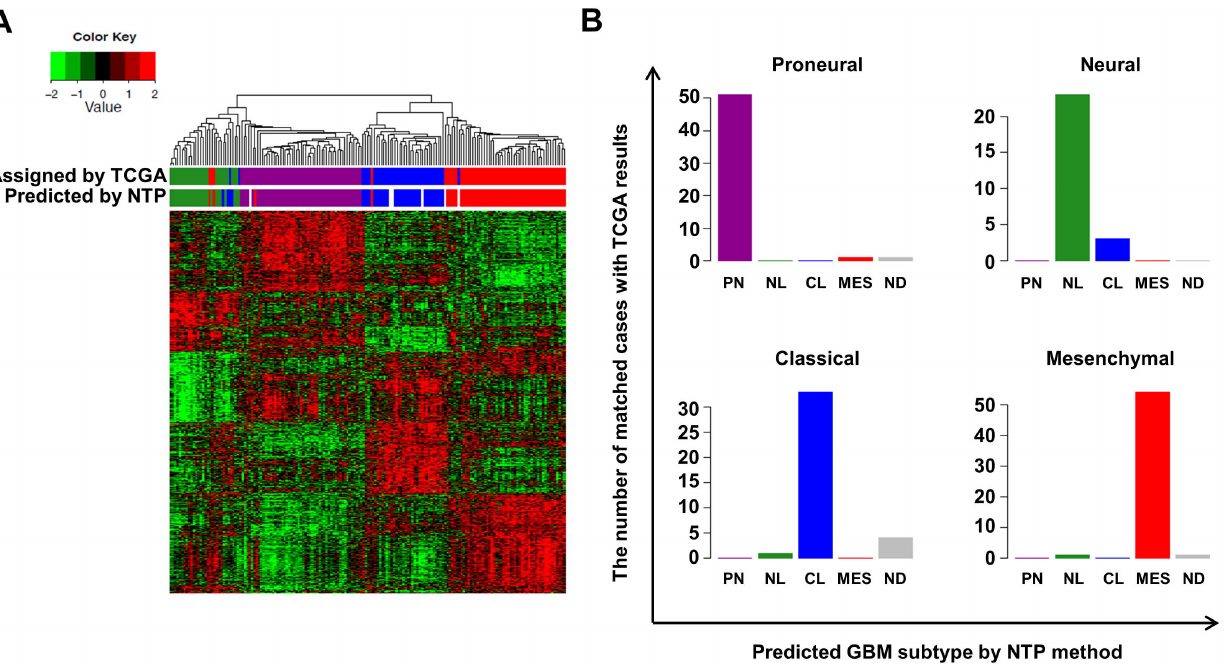
Figure 1. The ‘NTP method’ predicting GBM subtypes. ( A ) Hierarchical clustering using expression of 840 genes of 173 TCGA core GBM samples. The hierarchical clustering results were compared with the results of the NTP method (Predicted by NTP) and the previous reports by TCGA (Assigned by TCGA). Green, purple, blue, and red=neural (NL), proneural (PN), classical (CL), and mesenchymal (MES) subtype, respectively. ( B ) Subtype classification by the NTP methods was compared with corresponding subtypes assigned by TCGA. ND=not-determined.